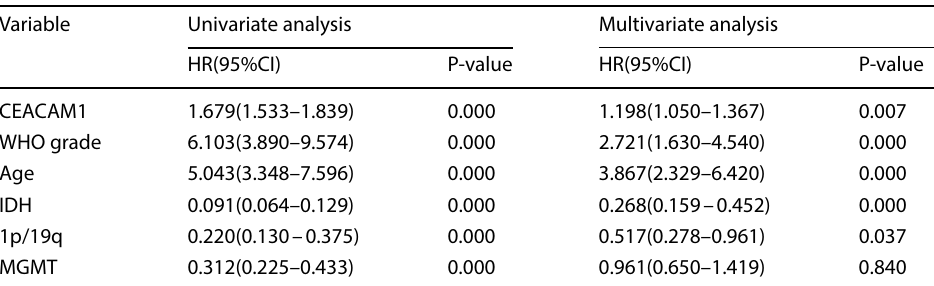
CI Confidence interval; HR Hazard ratio; IDH Isocitrate dehydrogenase; WHO World health